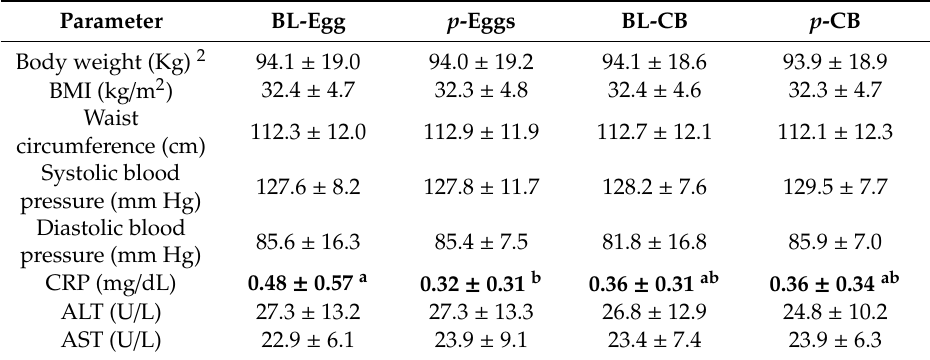
Table 3. Anthropometrics, blood pressure, C reactive protein (CRP), creatinine and liver enzymes, alanine aminotransferase (ALT), aspartate aminotransferase (AST), at baseline (BL) and post ( p ) intervention with egg and choline bitartrate (CB) supplement 1